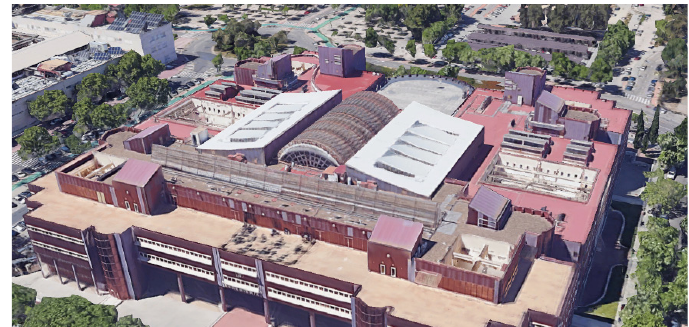
Figure 22. School of Engineering of the University of Sevilla. Aerial view of Conoidal Skylights.